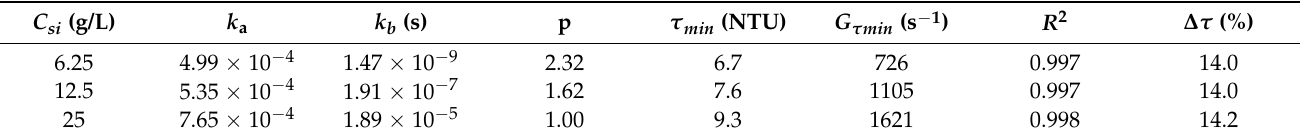
( B ) Figure 5. Relative ratio of floc quartile diameter d10. ( A ) and mean floc diameter d F ; ( B ) to Kolmo- gorov microscale as a function of the velocity gradient.